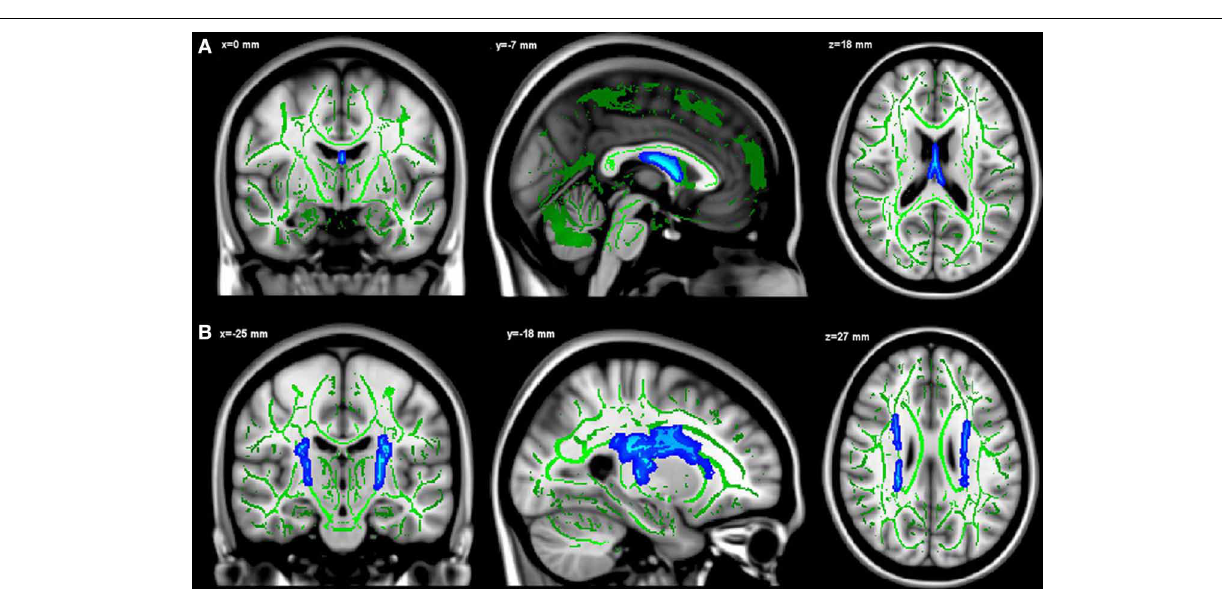
FIGURE 2 | Positive (A) and negative (B) relationships between hippocampal fractions and FA values. Significant voxels are shown in blue. The results are displayed at p < 0 . 05, TFCE corrected and overlaid simultaneously on the mean FA skeleton (green) and the MNI